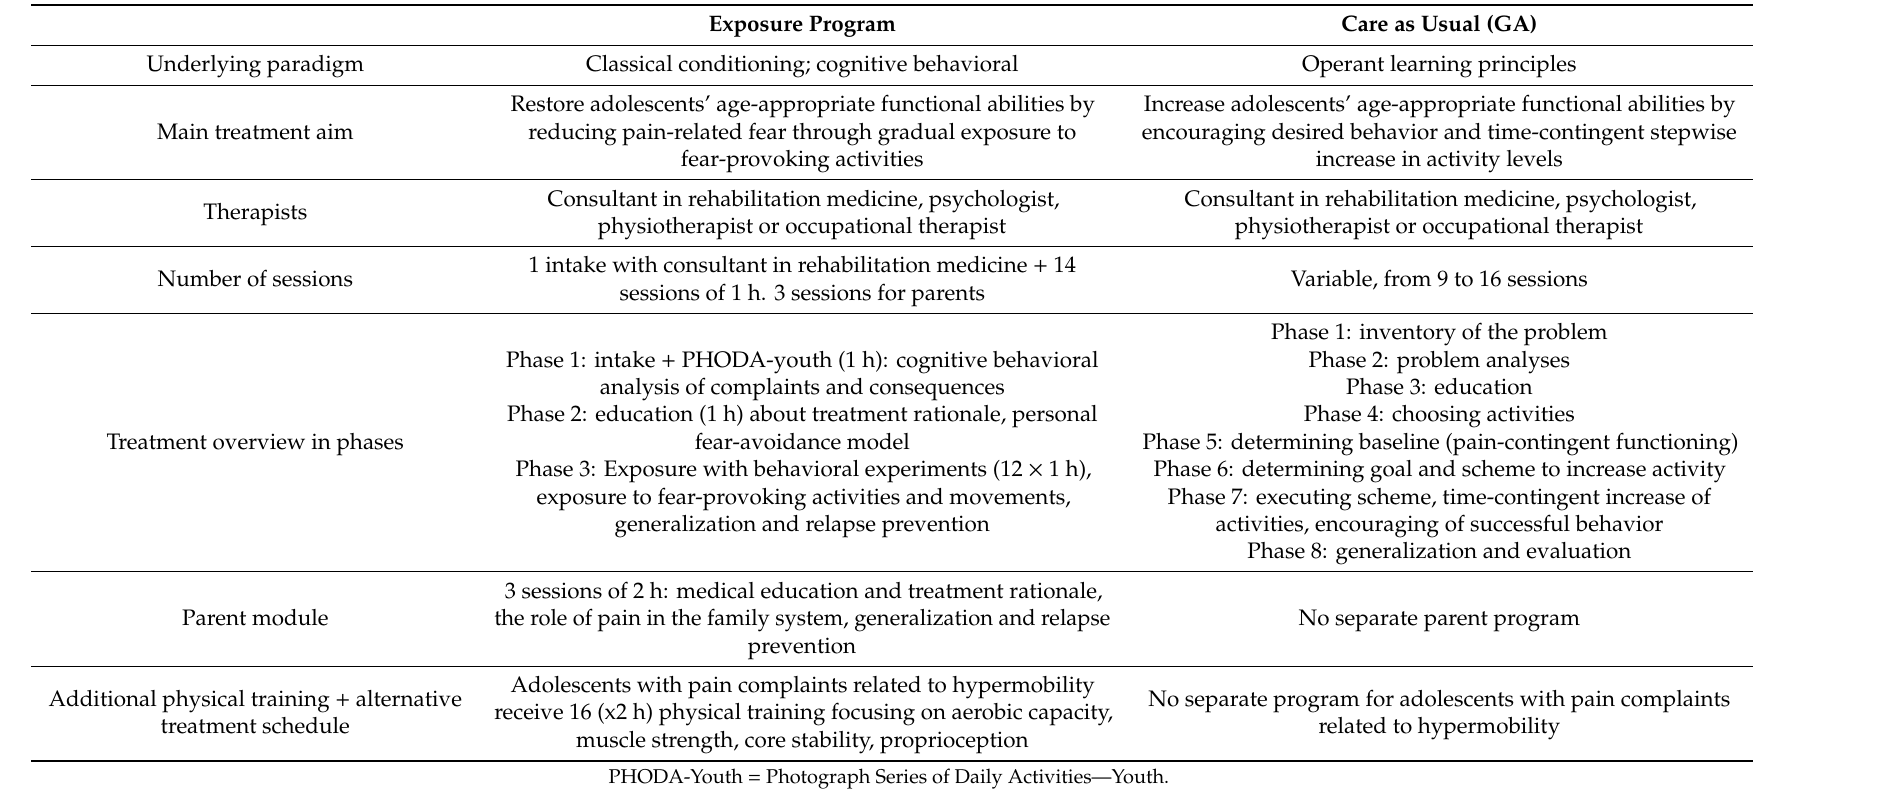
Table 1. Summary of contents of the exposure and care-as-usual